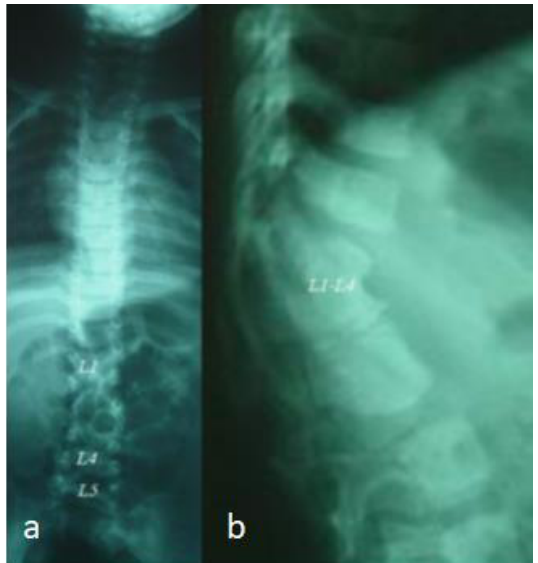
Figure 10. AP spine radiograph showed diffuse malsegmentation of L1 – 4 and spina bifida occulta of L5 ( a ); Lateral spine radiograph showed progressive lumbar kyphosis ( b ).